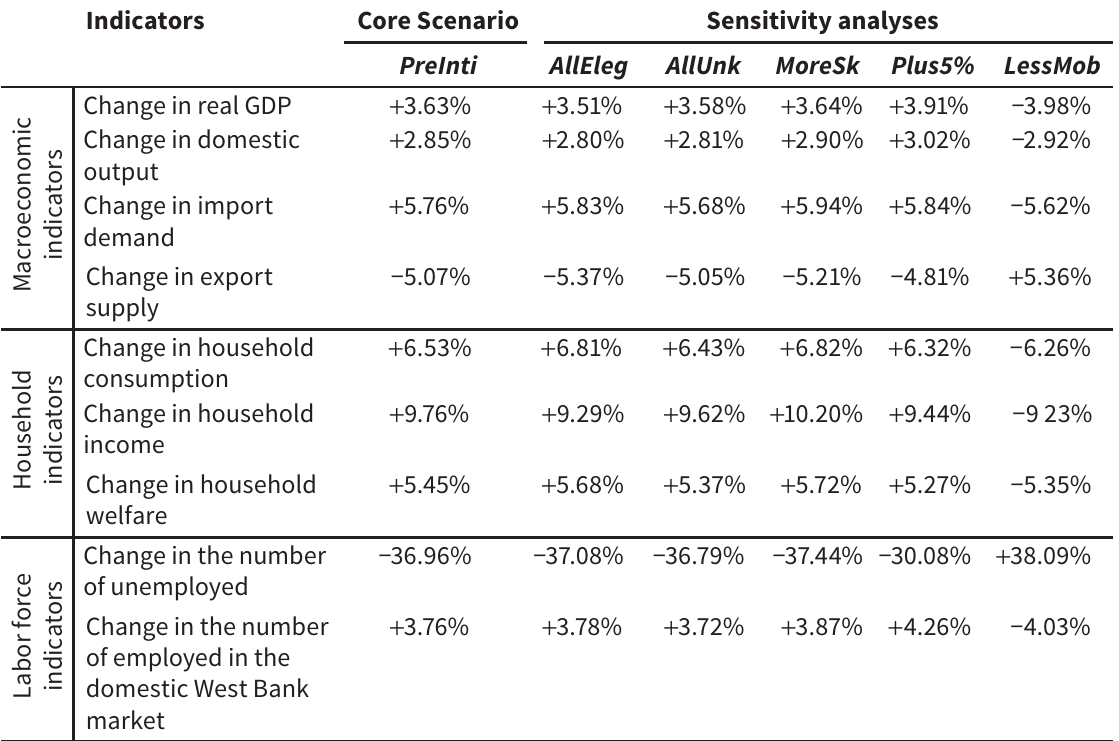
Table 3 Changes in macroeconomic, household and labor force indicators compared to the Base under the sensitivity analyses and the scenario